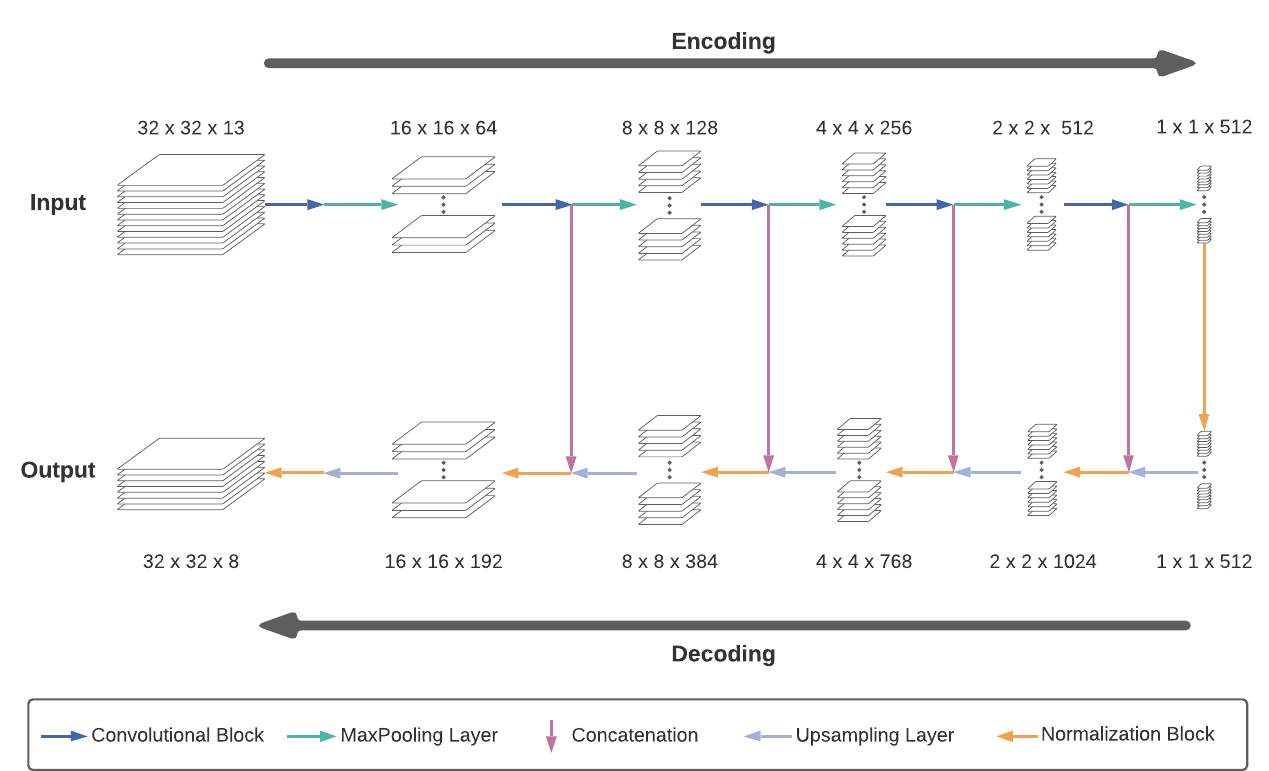
Figure 4. Schema of the employed fully convolutional neural networks (FCN). Numbers indicate the dimensions of the intermediate data in order (height × width × channels). Colored arrows represent different operations on the data. These can be single neural network layers (MaxPooling, Upsampling), blocks of several layers (Convolution Block, Normalization Block), or the concatenation of data. Adapted from Sefrin